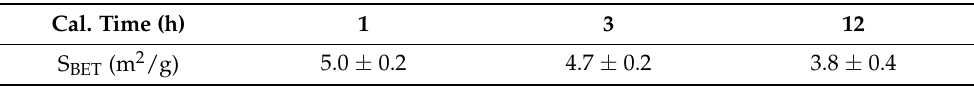
Figure 4. Effect of calcination time of Ni-UGSO catalyst with 13% Ni (wt%): evolution of CH 4 conversion as a function of time (CO 2 /CH 4 = 1.2, 840 ◦ C). Table 2. Average catalyst surface BET as function of calcination time of Ni-UGSO catalyst with 13% Ni (wt%).